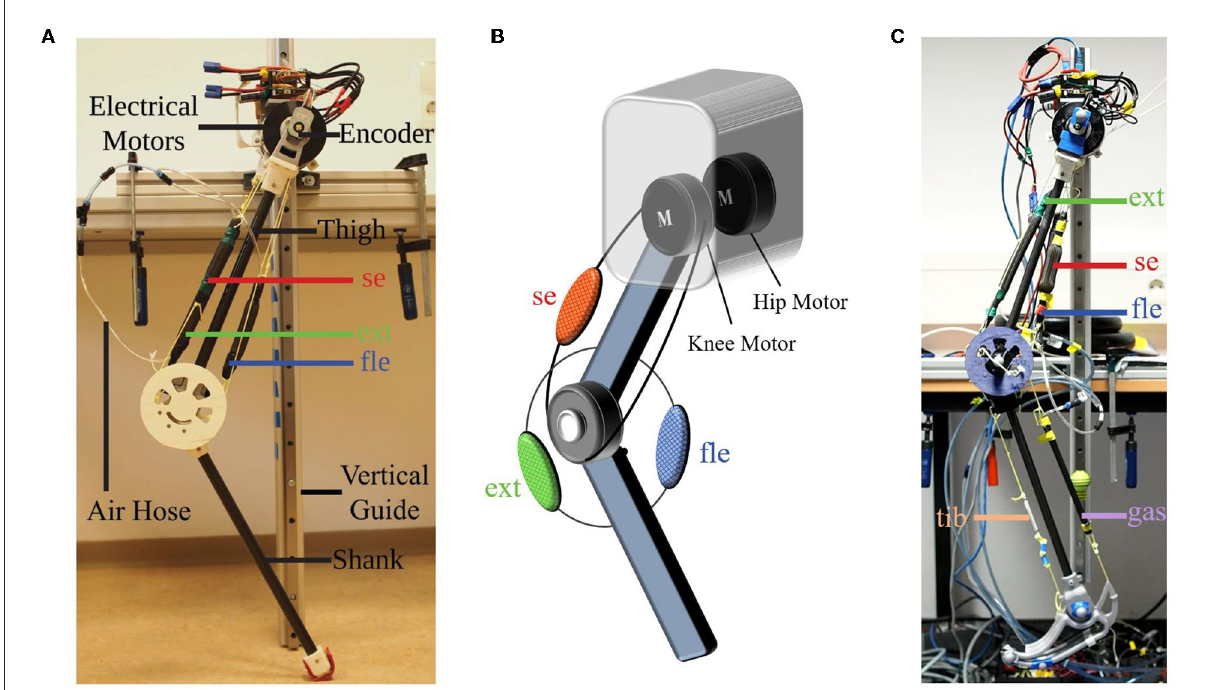
FIGURE1 Electric-pneumatic actuation (EPA)-Hopper robot. (A) A photo of EPA-Hopper. (B) The schematic illustration of EPA-Hopper’s actuation system. EPA-Hopper is a two-DoF leg co-actuated by two electric motors and three pneumatic artificial muscles (PAM) acting on the knee joint. (C) A photo of EPA-Hopper II, an extension of EPA-Hopper comprising an ankle joint and a foot. se , fle , and ext indicate the serial, flexor, and extensor PAMs, respectively. gas and tib indicate the biarticular gastrocnemius PAM and the ankle dorsiflexion spring, respectively.